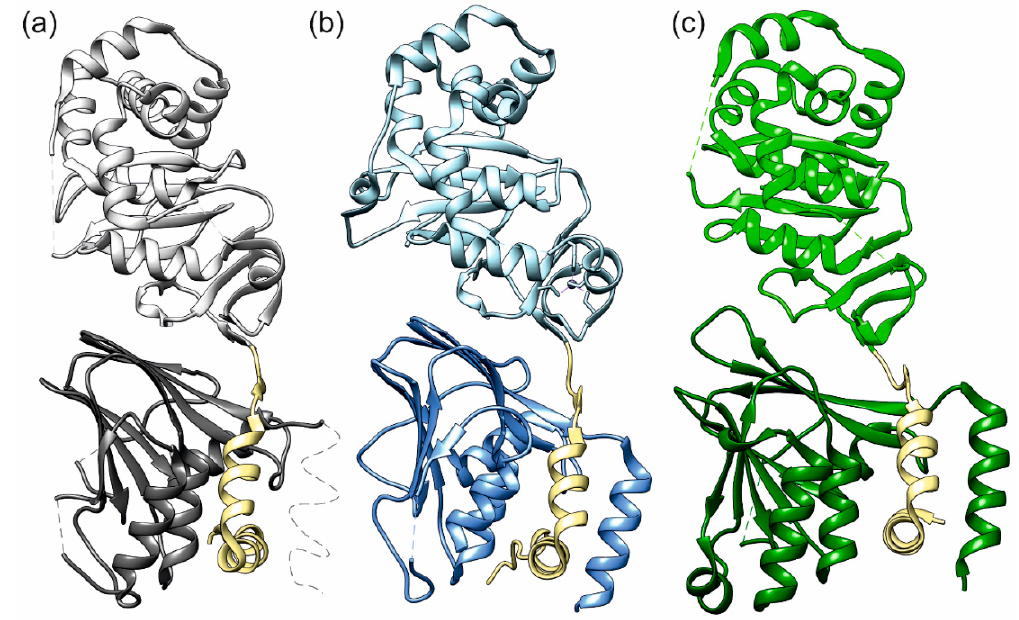
Figure 1 . NECs (nuclear egress complexes) of the three herpesviruses ( a ) HSV ‐ 1 (herpes simplex virus 1), ( b ) PRV (pseudorabies virus), and ( c ) HCMV (human cytomegalovirus). The membrane proximal proteins (pUL50, pUL34) are in a darker shade than the lightly coloured membrane distal proteins (pUL53, pUL31). The hook regions are coloured khaki. Thin dotted lines indicate protein segments not resolved in the crystal structures.